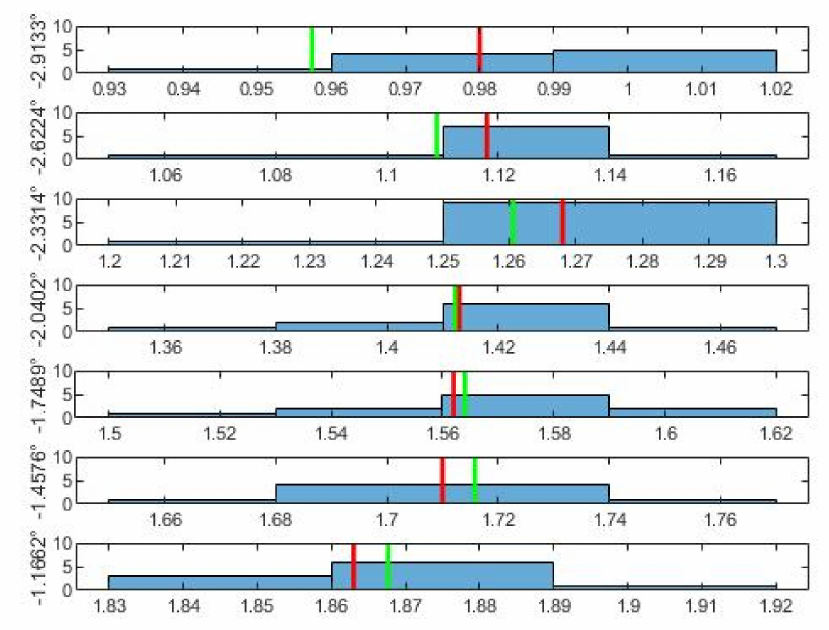
Figure 5. Histograms of the first 7 measurements. On the left is the appropriate angle and multitude. The red line is the mean u ; the green line is the LSM value of u appropriate to the